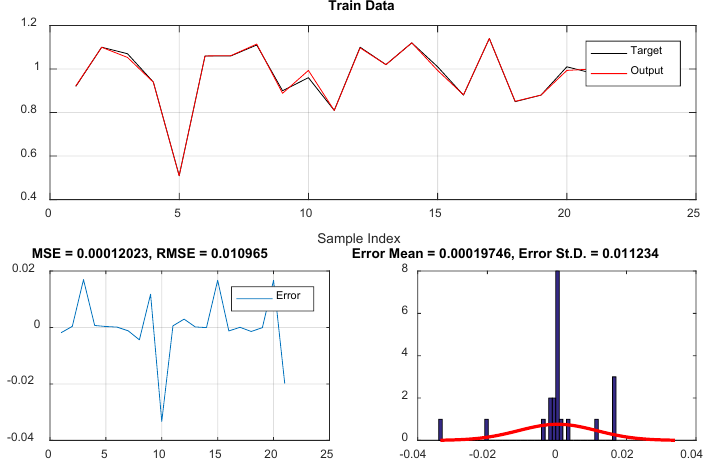
Figure 19. Error and training behavior of ANFIS-GA model. Figure 19 . Error and training behavior of ANFIS-GA model . Figure 19 . Error and training behavior of ANFIS-GA model .